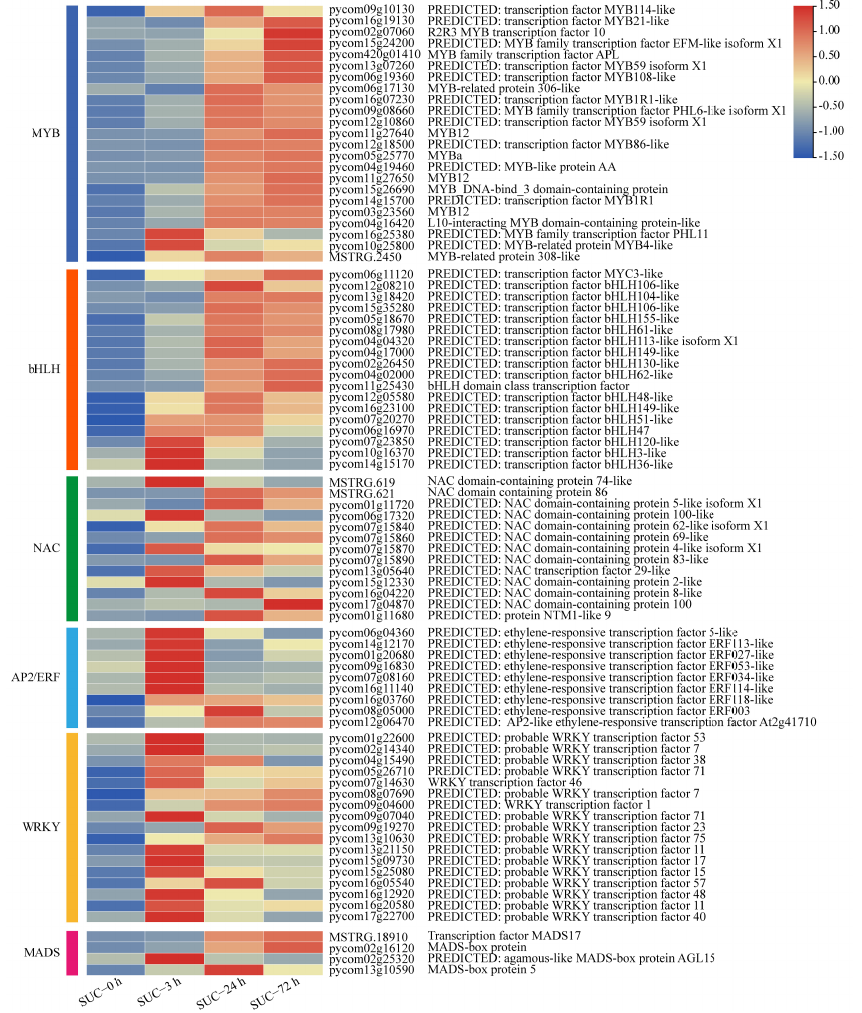
Figure 7. The expression profiles of different transcription factor families under sucrose treatment. Heatmap of the expression levels of sugar transporter genes using the TBtools with the data nor- malized to log scale and row scale. Red indicates high expression level and blue indicates low expression